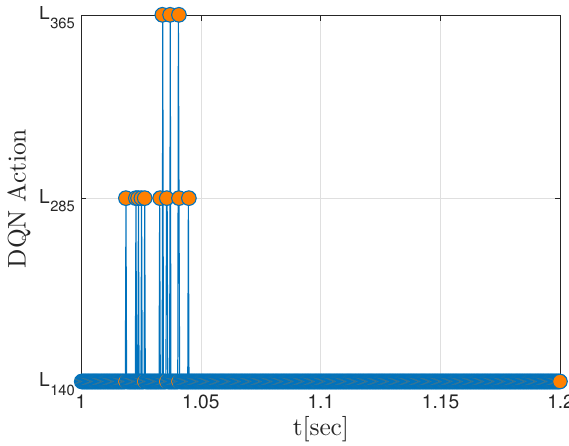
Figure 12. DQN action progression.